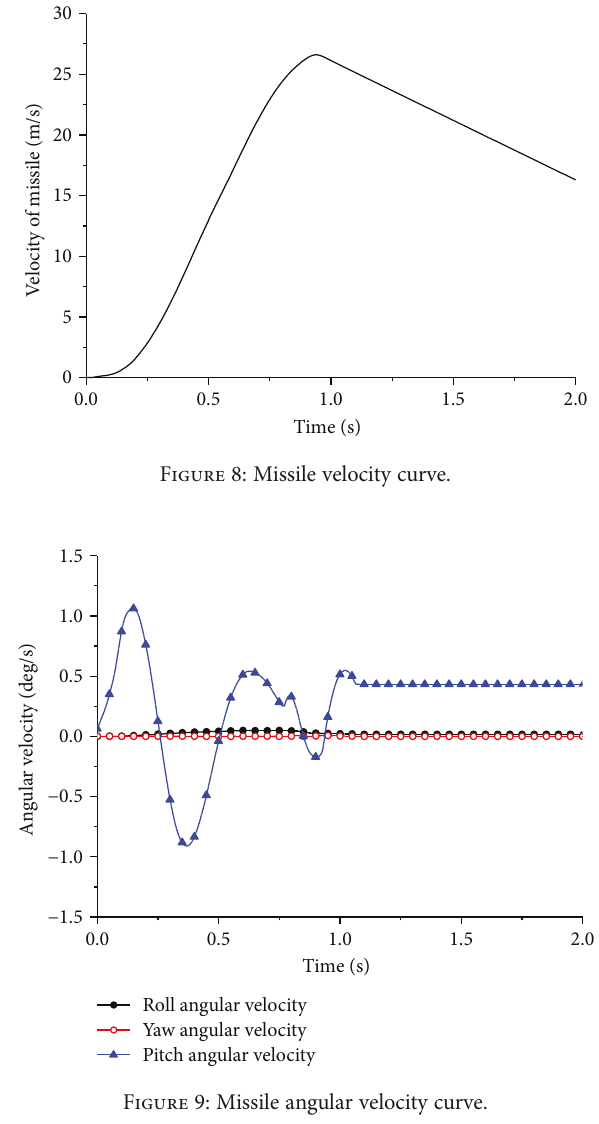
Figure 9: Missile angular velocity curve.